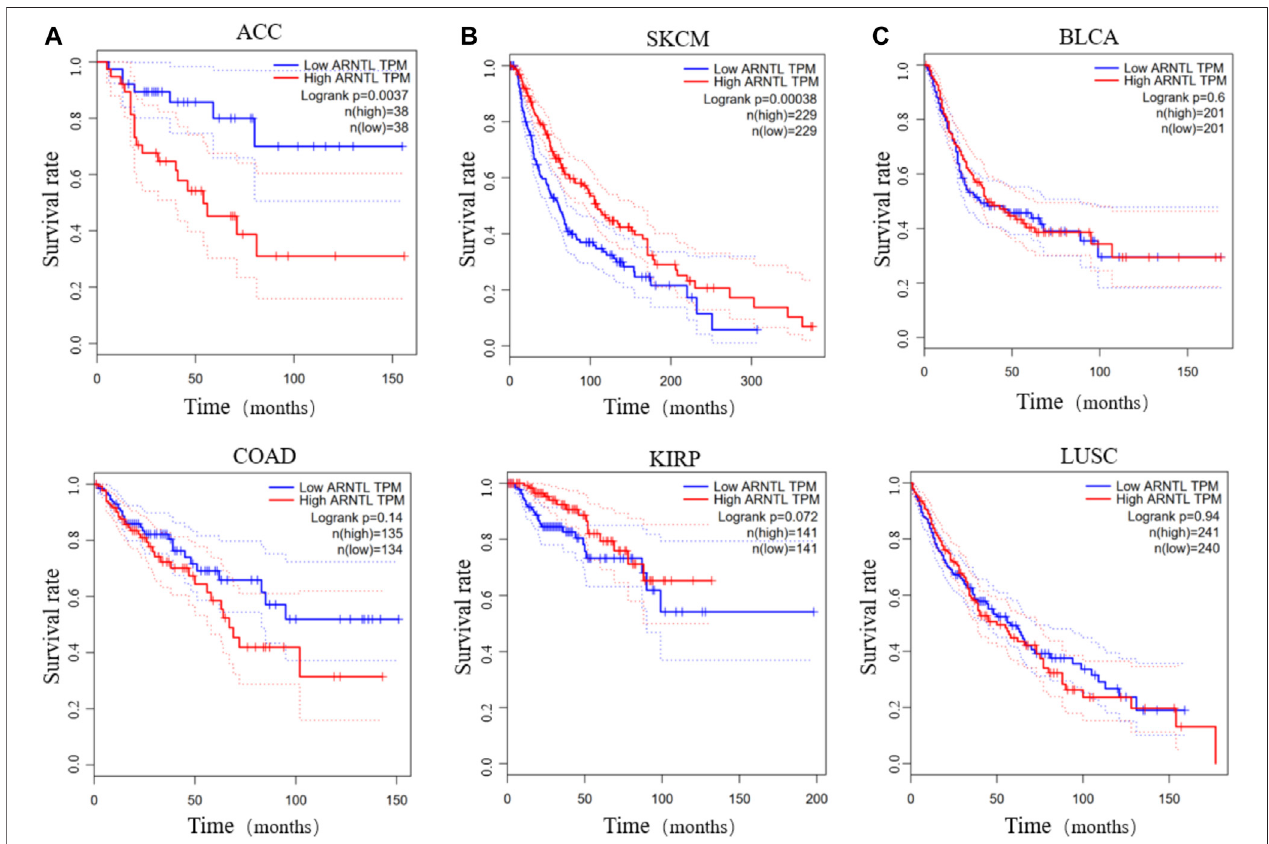
FIGURE2| Thesurvivalrateoflowandhigh BMAL1 TPMindifferentcancers.Low BMAL1 TPMrelatestoahighoverallsurvivalrateinpatientswithACCorCOAD (A) . High BMAL1 TPM relates to a high overall survival in SKCM or KIRP (B) . The expression of BMAL1 is irrelevant in BLCA or LUSC (C) .